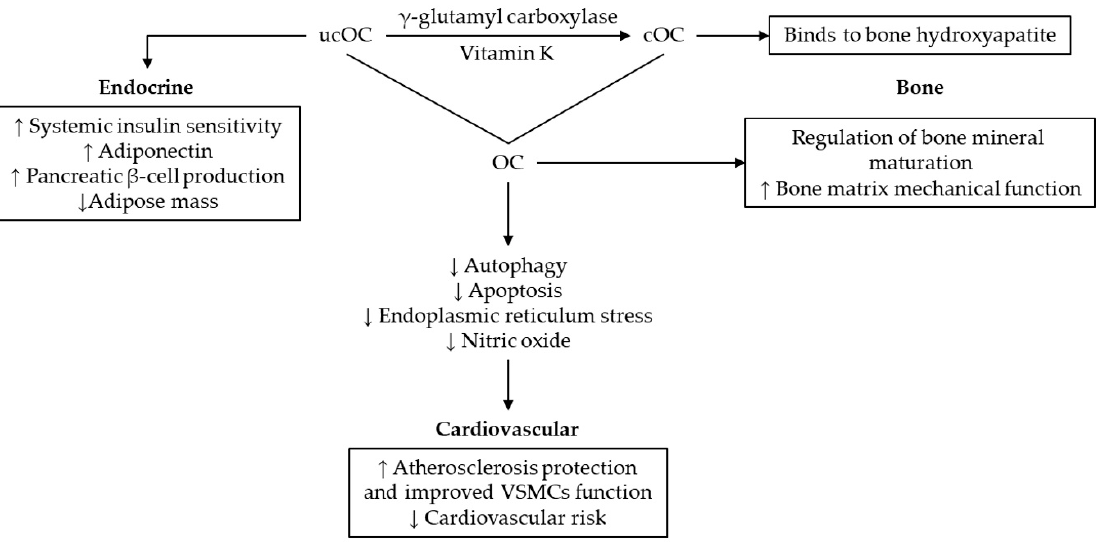
Figure 3. Systemic and bone specific effects of OC. Abbreviations: OC, osteocalcin; ucOC, uncarboxylated OC; cOC, carboxylated OC; VSMCs, vascular smooth muscle cells.